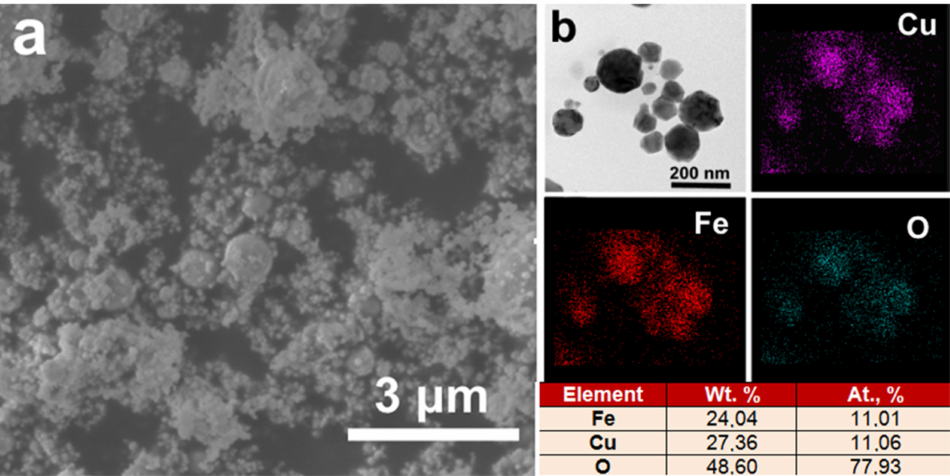
Figure 2. SEM image of CuFe 2 O 4 /Cu 2 O/CuO NPs ( a ) and TEM and EDX mapping showing copper, iron, and oxygen distribution in NPs ( b